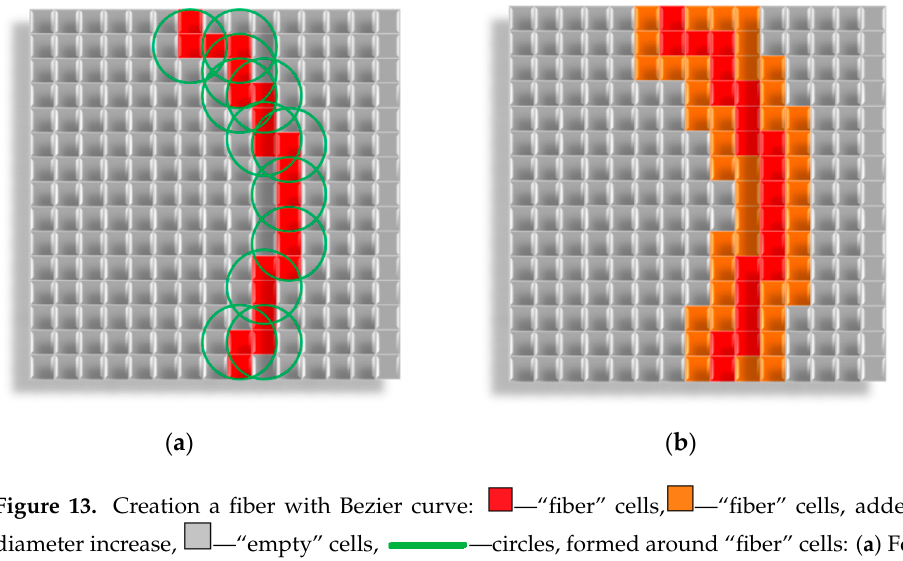
Figure 13. Creation a fiber with Bezier curve: —“fiber” cells, —“fiber” cells, added after diameter increase, —“empty” cells, control points, —Bezier curves —circles, formed around “fiber” cells: ( a ) Forming circles around “fiber” cells; ( b ) Changing states of cells inside circles into